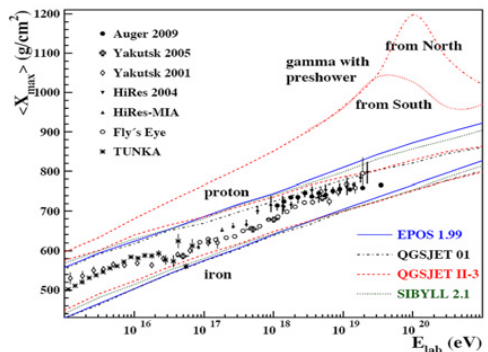
Figure 2. Dependence of X max from energy. Experimental data comparison with calculations for different hadron interaction models (proton, iron nuclei and high-energy gamma ray).